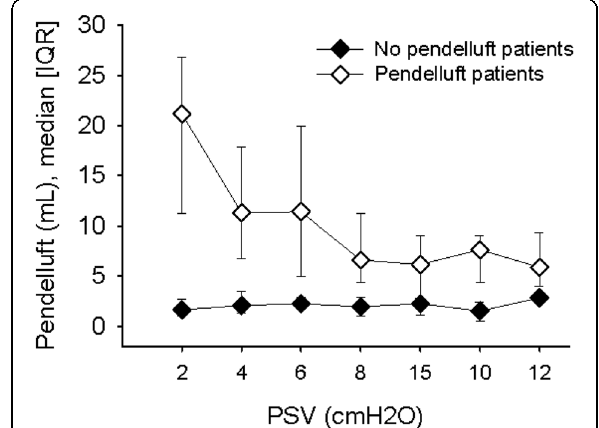
Fig. 3 (abstract 000732). See text for